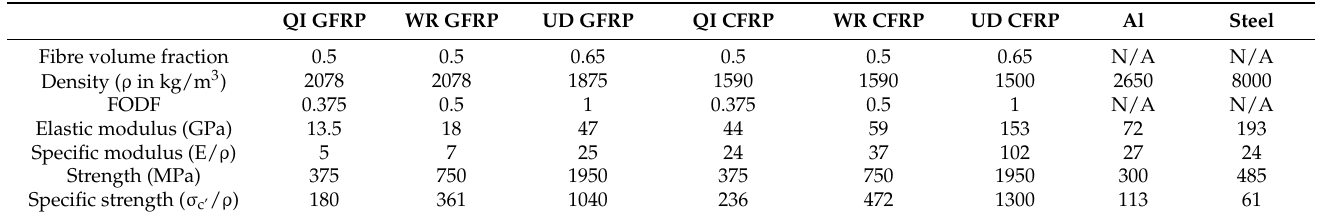
Table 2. Comparison of material properties (CFRP = carbon fibre composites, GFRP = glass fibre reinforced composites, Al = 5083 aluminium, steel = 316 L grade, specific properties converted to display as